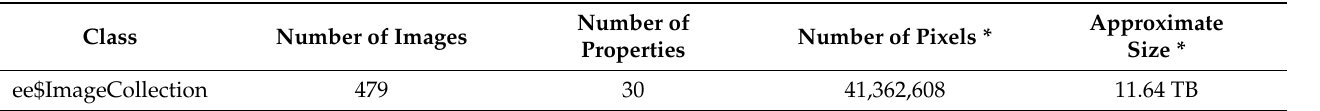
Table 1. Earth Engine MODIS/006/MOD13Q1 select (‘NDVI’)-ImageCollection Metadata, filter Date